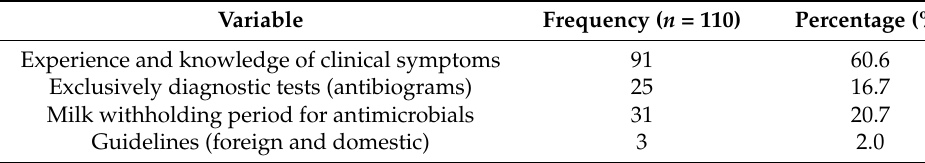
Table 13. Prescribing habits for cow mastitis